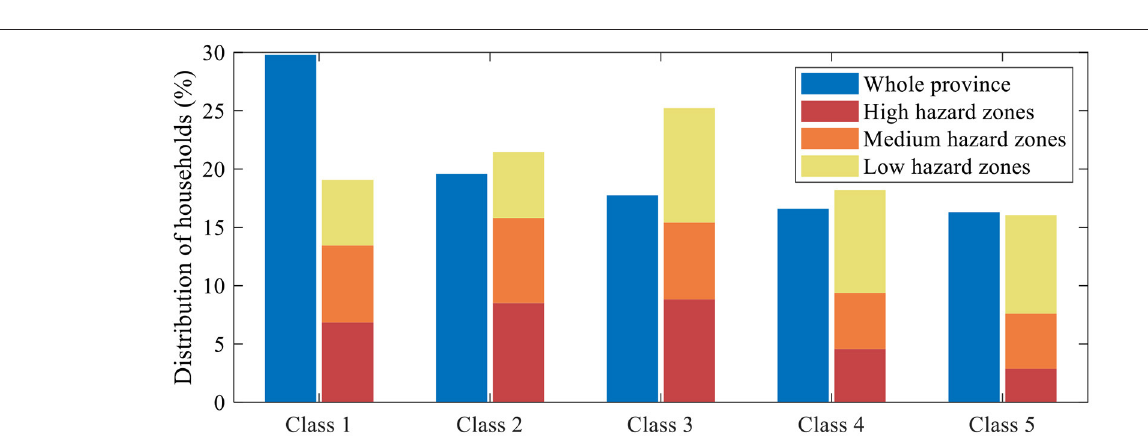
in ISD classes 1 and 5 than for the rest of the